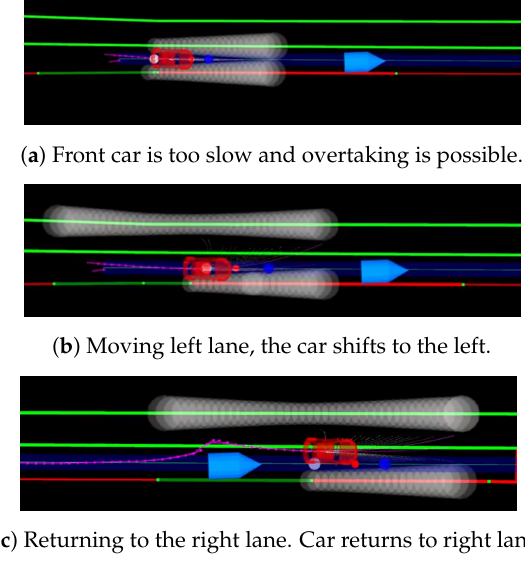
Figure 10. Overtaking